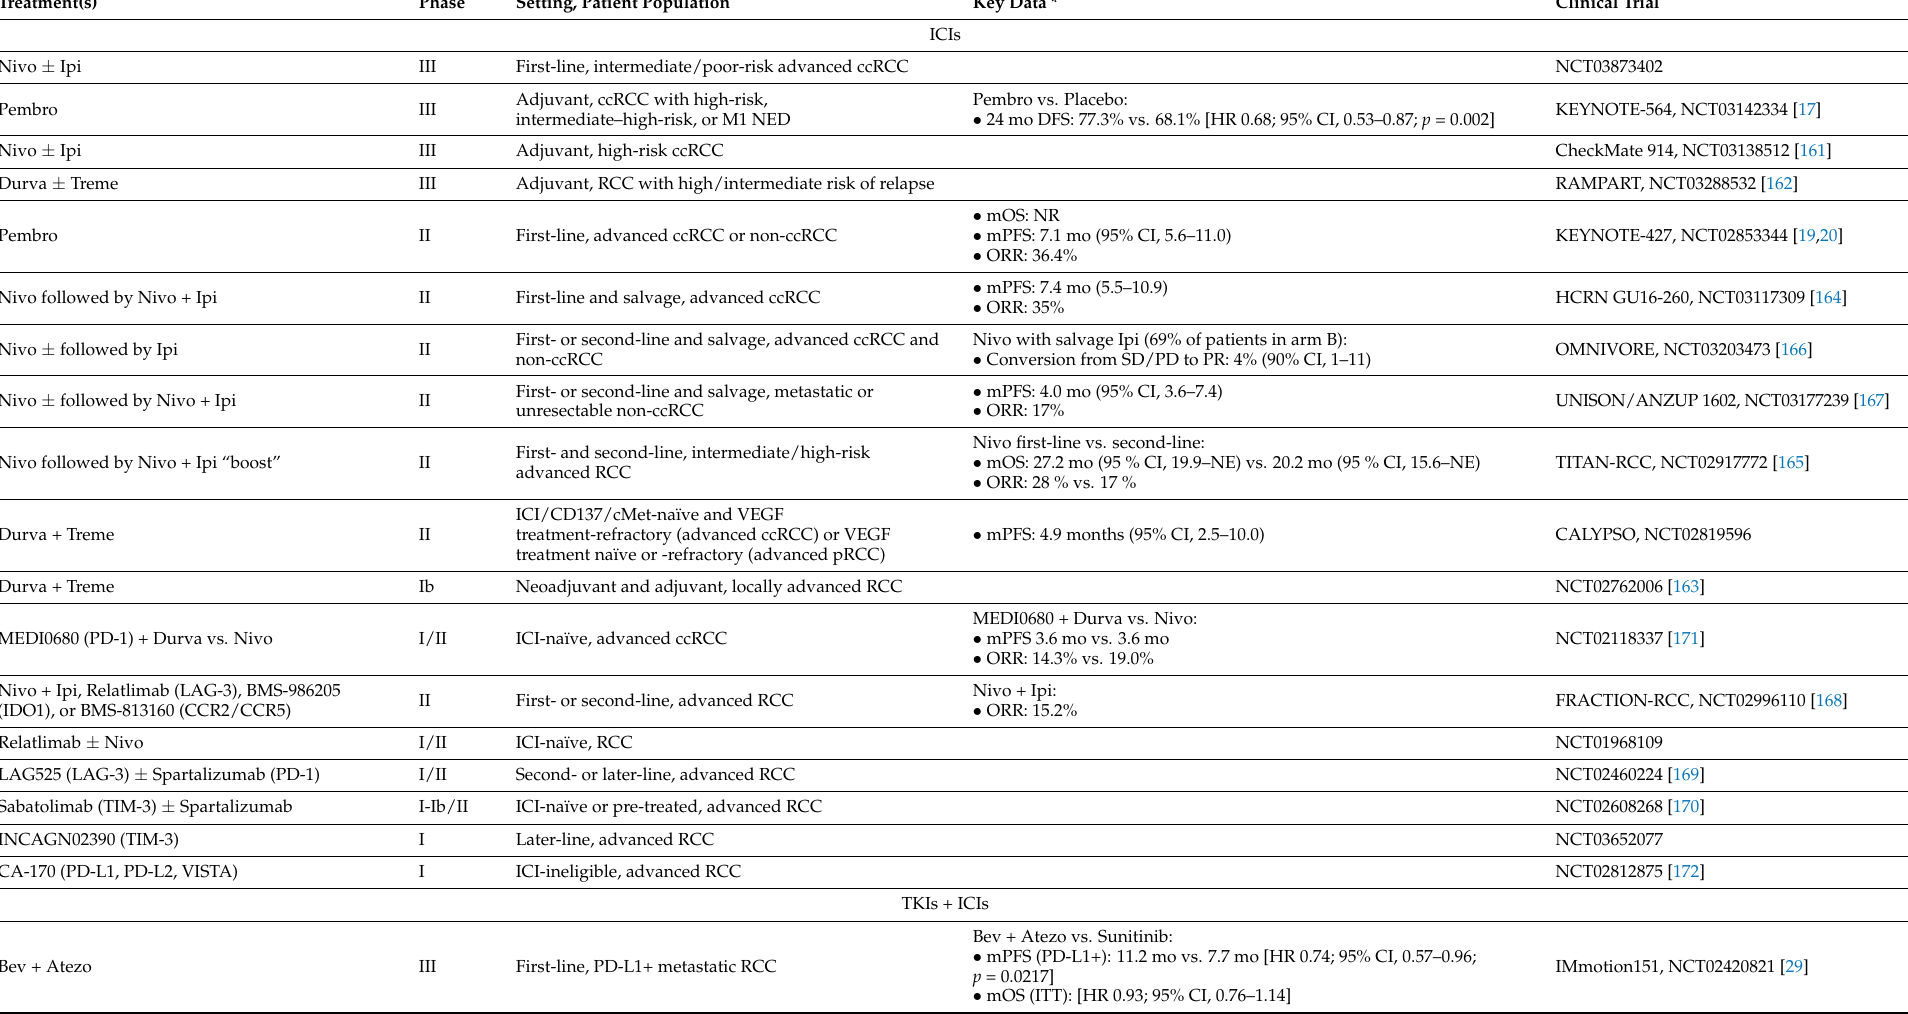
Table 2. Ongoing and completed clinical trials for non-approved immunotherapies for